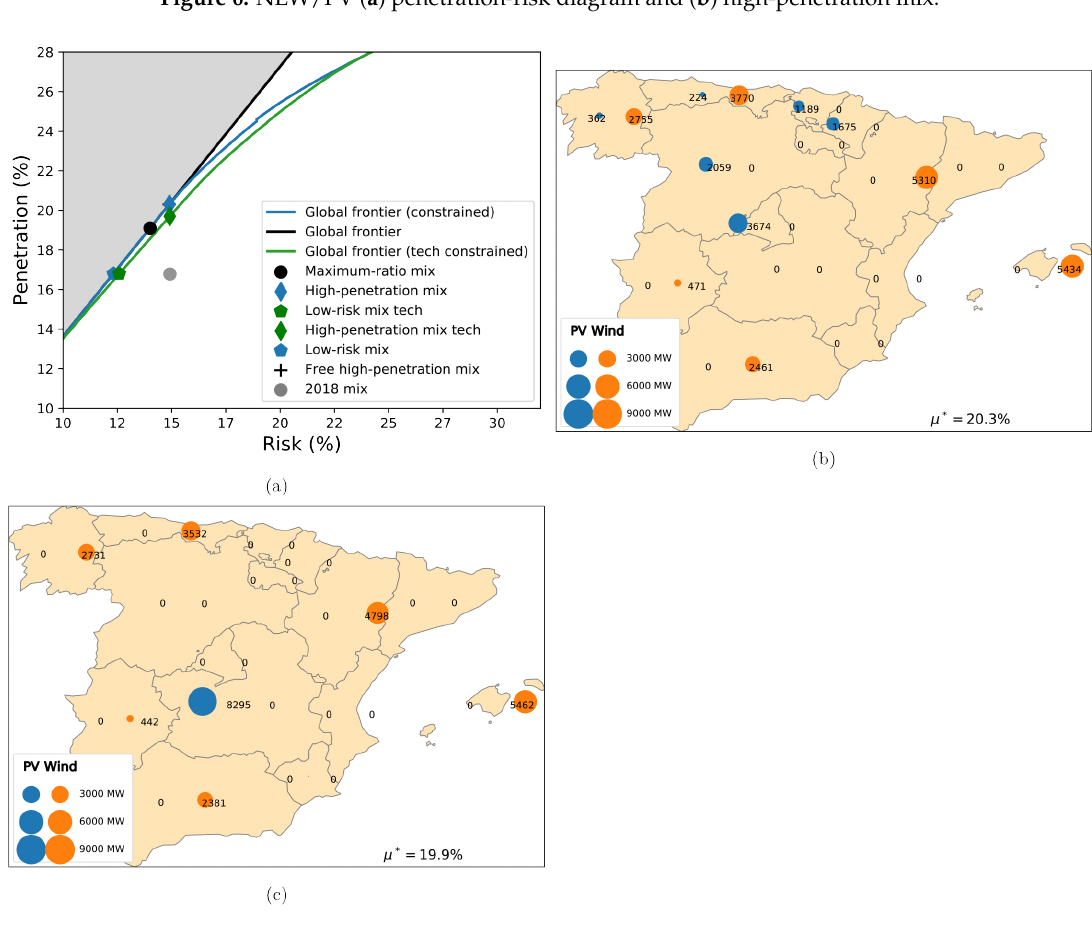
Figure 7. NEW/NOCAL ( a ) penetration-risk diagram and ( b ) high-penetration mix. ( c ) NEW/UNIEFF high-penetration